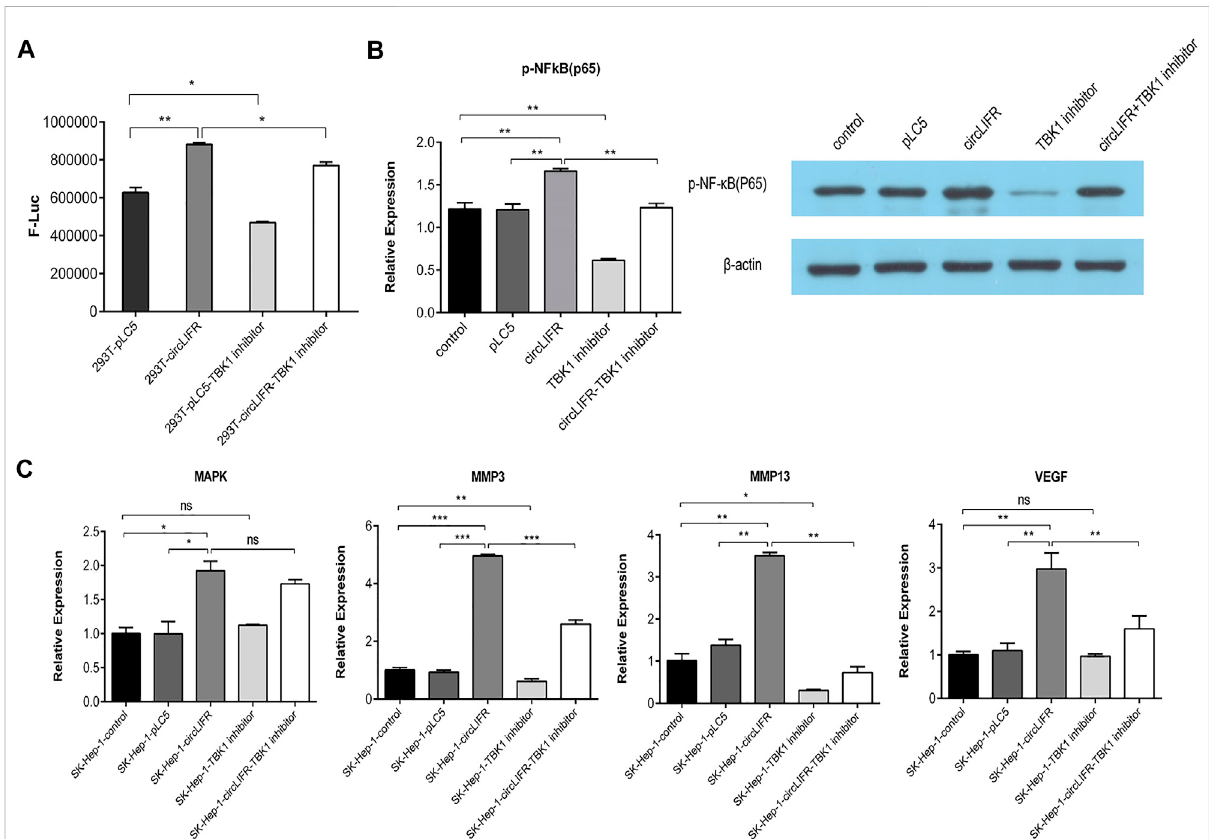
FIGURE 4 Interaction between circLIFR and TBK1 protein promotes NF κ B signal pathway activation and regulates the expression of genes related to proliferation and migration. (A) NF- κ B luciferase reporter system shows that overexpression of circLIFR counteract the inhibitory effect of TBK1inhibitorandactivatedtheNF- κ Bpathway toaffecttheactivityofNF- κ BbybindingtoTBK1; (B) WesternblottinganalysissuggeststhatcircLIFR overexpressionactivatedtheNF- κ Bpathway; (C) qRT-PCRanalysisshowsthattheoverexpressionofcircLIFRinteractedwithTBK1toaffectthe levels of oncogenes downstream of NF- κ